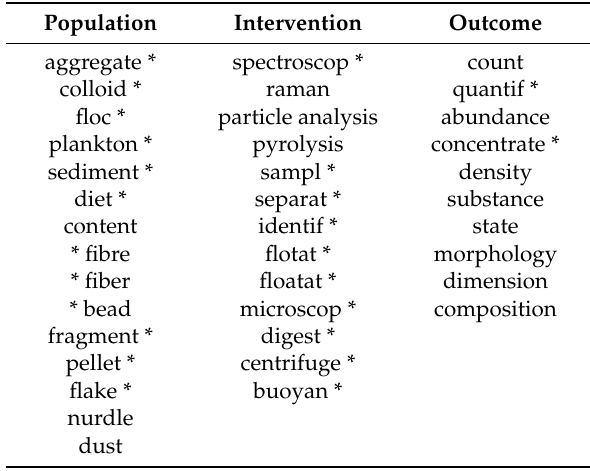
Table 1. Search terms used to identify the evidence available on sampling and analytical methods used to characterise microplastics in freshwaters and